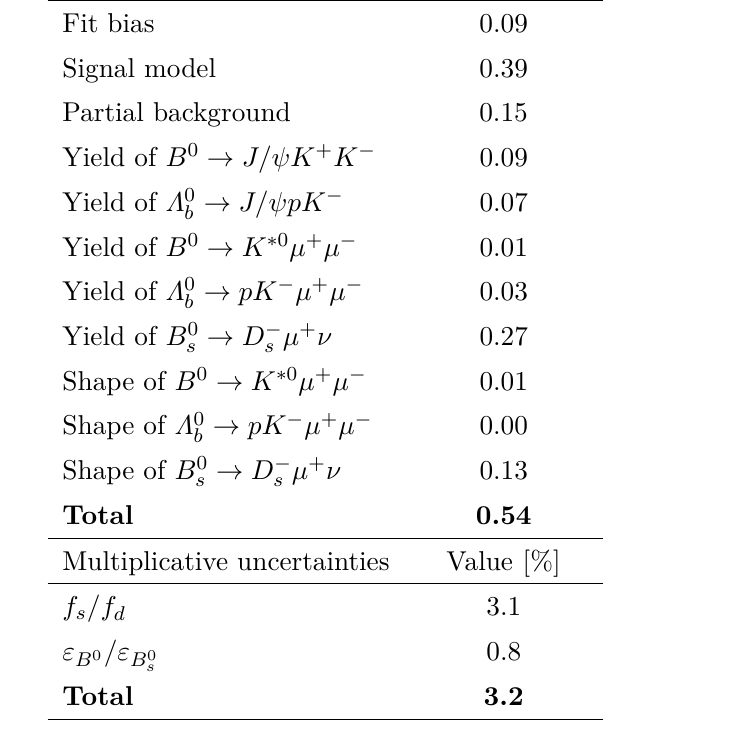
Table 2. Systematic uncertainties on the measurement of R for additive and multiplicative sources.